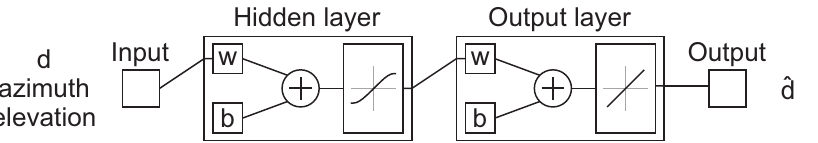
Figure 6. Feedforward neural network with six neurons in the hidden layer. The neural network (NN) has three input parameters—measured distance, azimuth and elevation angles, and one output parameter—corrected